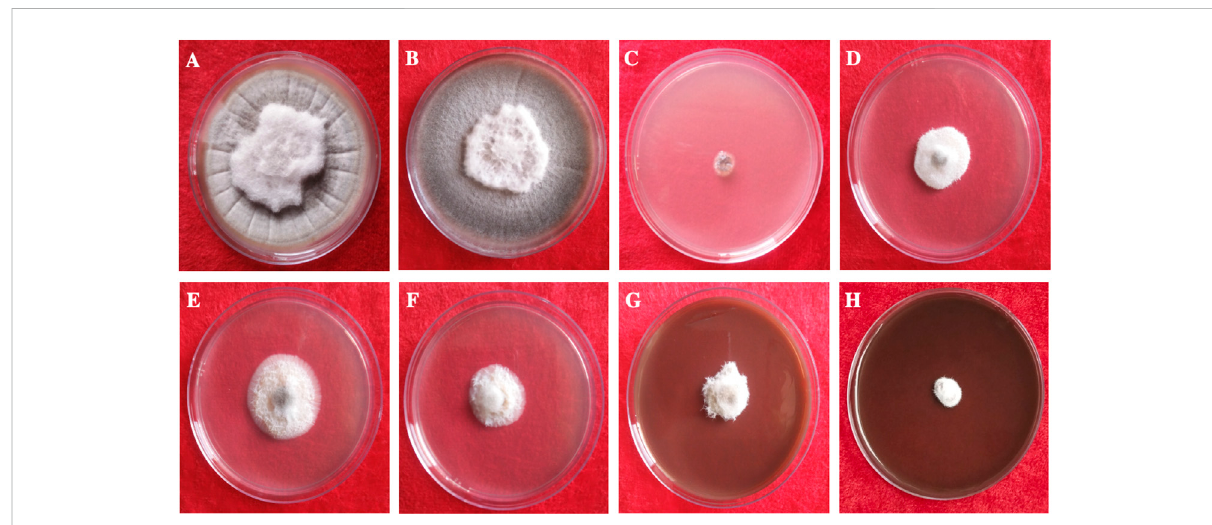
FIGURE 14 In vitro antifungal of synthesized AgNPs against Alternaria alternata . (A) Control, (B) Plant extract (C) Bavistin, (D) AgNO 3 , (E – H) 25, 50, 75, 100 μ g/ml AgNPs.